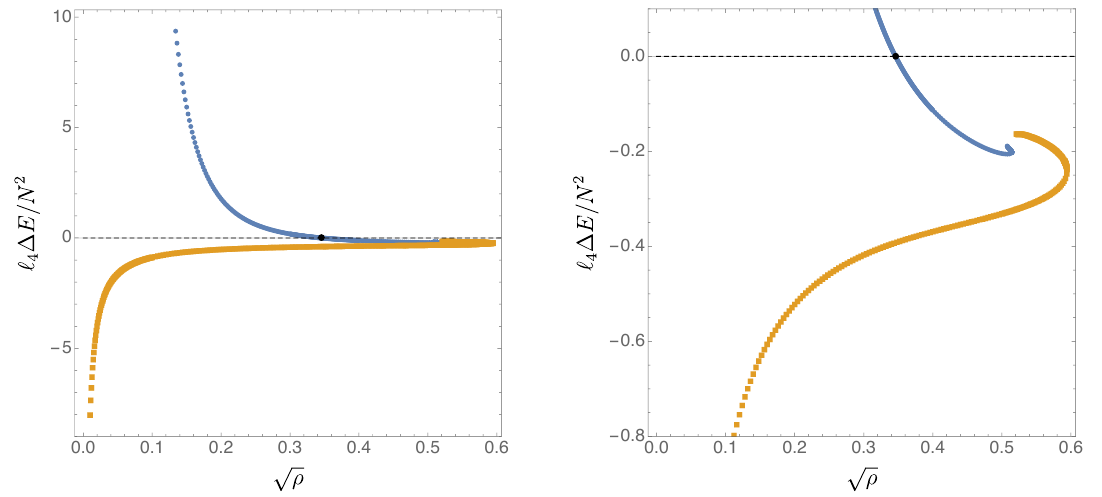
Figure 12 . The energy of various phases with (cid:12)xed SAdS 4 boundary metric parametrised by (cid:26) : the orange squares represent the droplets and the blue disks the funnels. The right panel shows a close- up of the region close to where funnels and droplets appear to merge. The black disk represents the transition between stable and unstable non-uniform funnels.